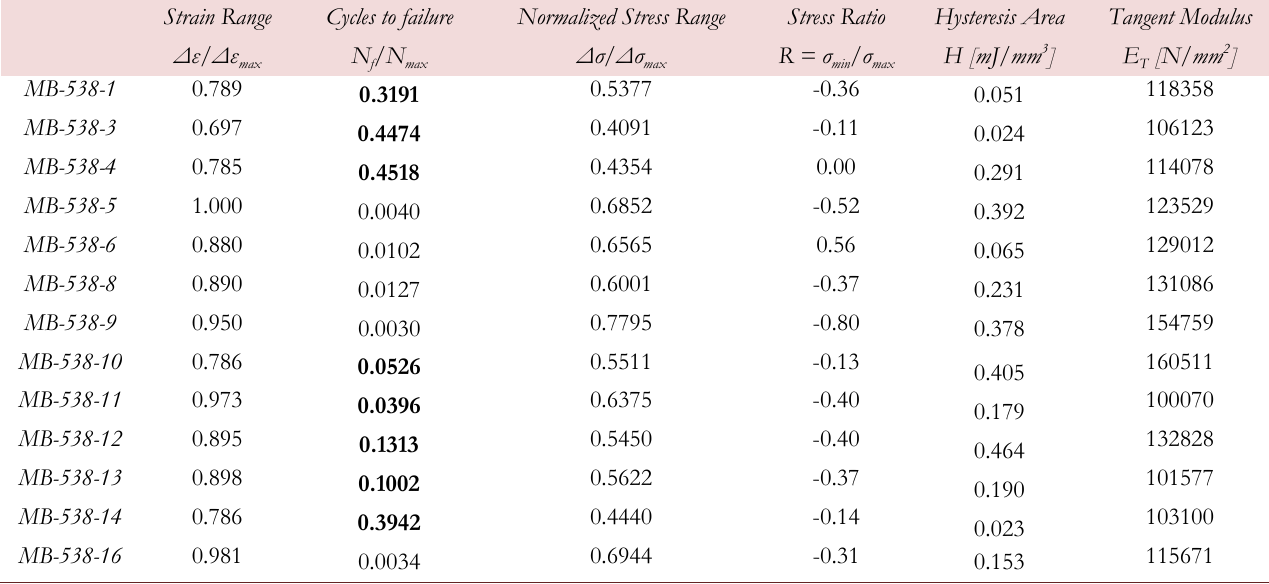
Table 3: Base Material – 538°C: fatigue test